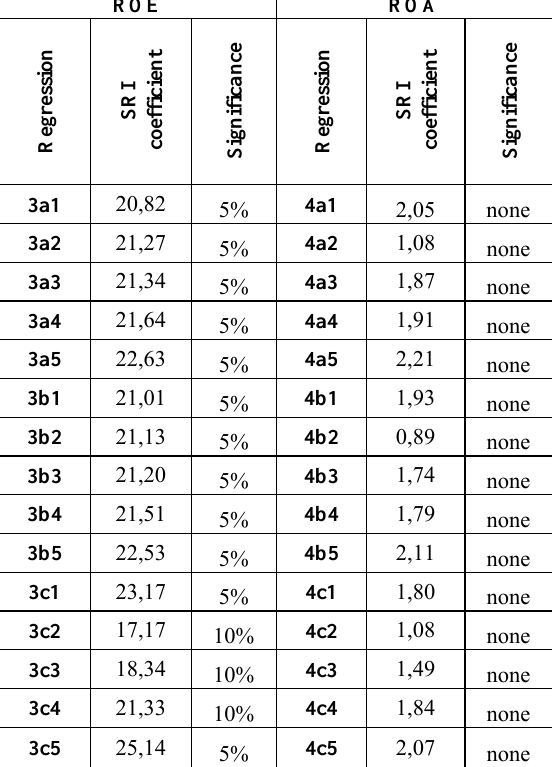
Table 6: Regression results for Callan & Thomas (2009) – fully specified model including quadratic